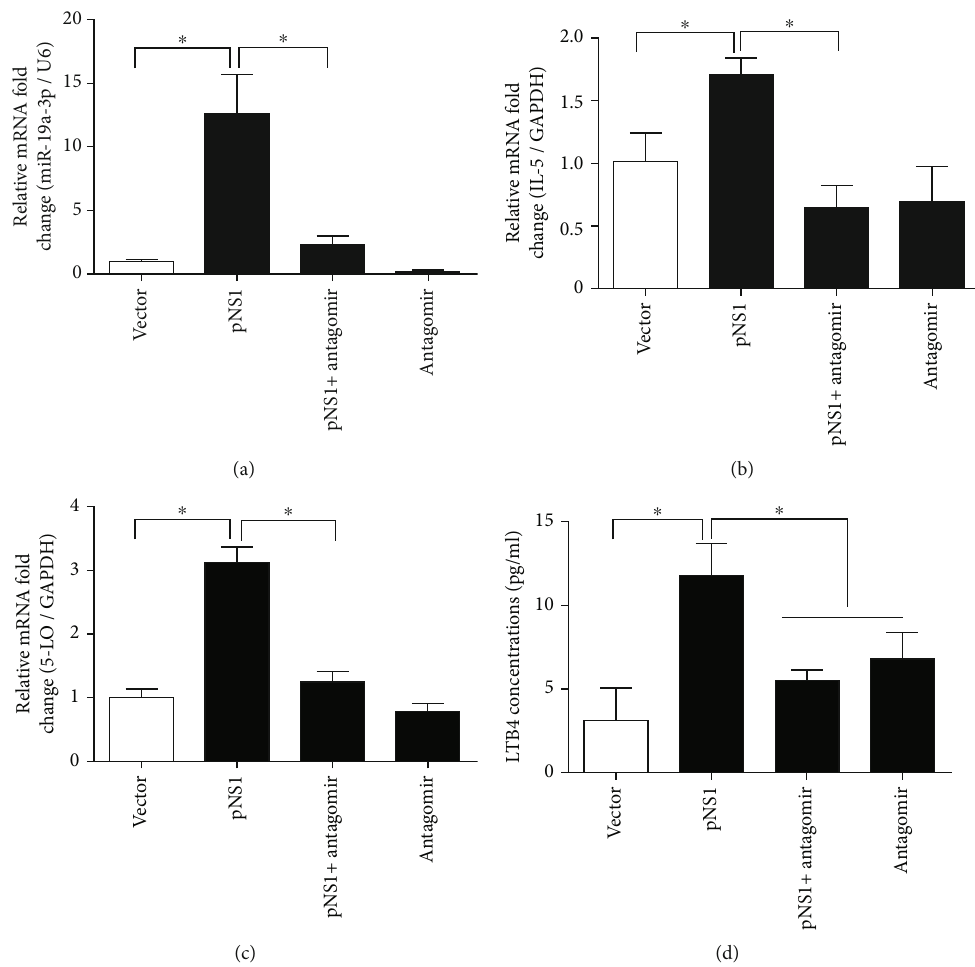
Figure 3: Inhibition of miR-19a-3p attenuated the promotive e ff ects of NS1 on 5-lipoxygenase (5-LO) and interleukin-5 (IL-5) expression. (a – c) The mRNA expression levels of miR-19a-3p, IL-5, and 5-LO in A549 cells transfected with pNS1 were detected by RT-qPCR four hours after transfection. U6 RNA or GADPH was used as internal control, respectively. (d) Concentrations of leukotriene B4 in the supernatants of A549 cells were detected by an enzyme-linked immunosorbent assay. Data are expressed as mean ± SD ( n = 3 technical replicates). The experiment was performed three times with similar results, and one representative experiment is shown. ∗ P < 0 : 5 vs. control group. LTB : leukotriene B4; 5-LO: 5-lipoxygenase; IL-5: interleukin-5; pNS1: nonstructural protein 1 expressing 4